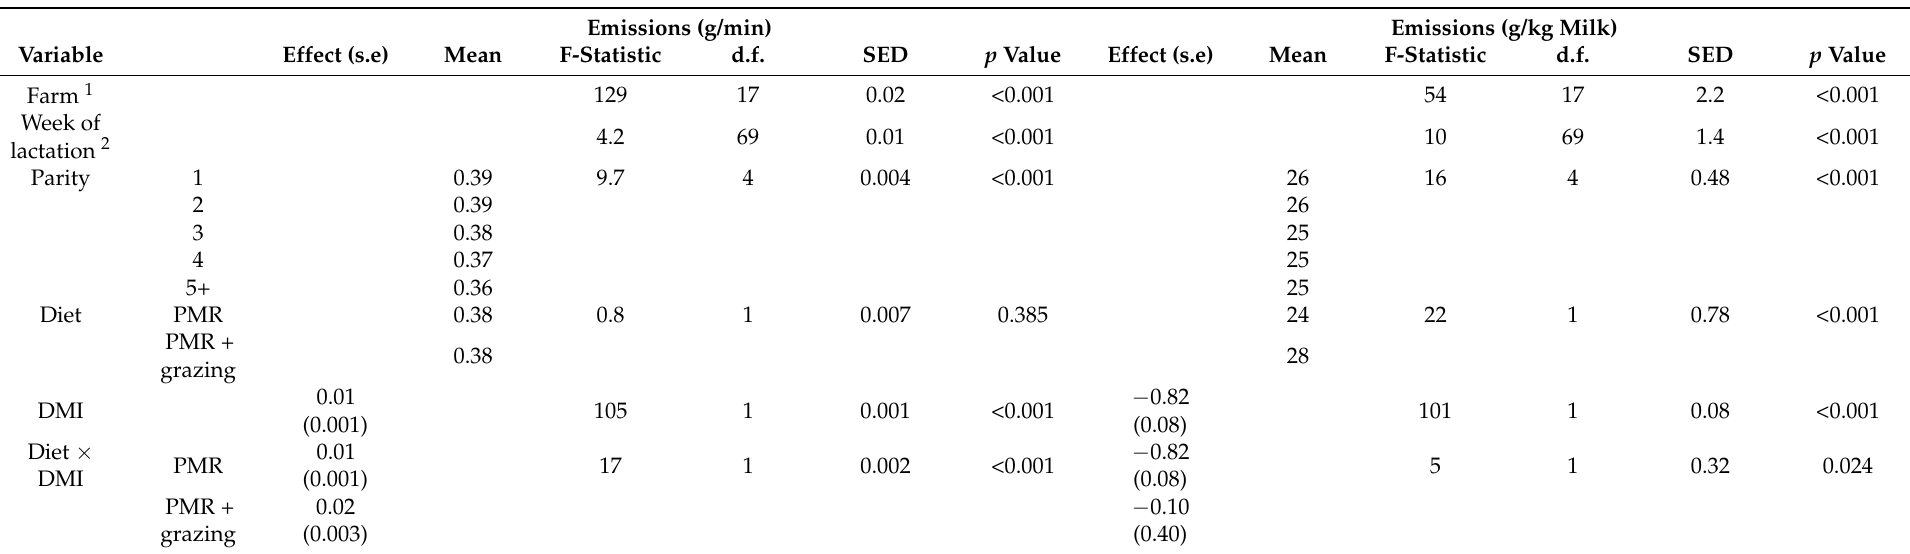
Table 3. Effect of farm, week of lactation, parity, diet and dry matter intake (DMI) on enteric methane emission rate (g/min) and per kg milk for dairy cows across commercial farms